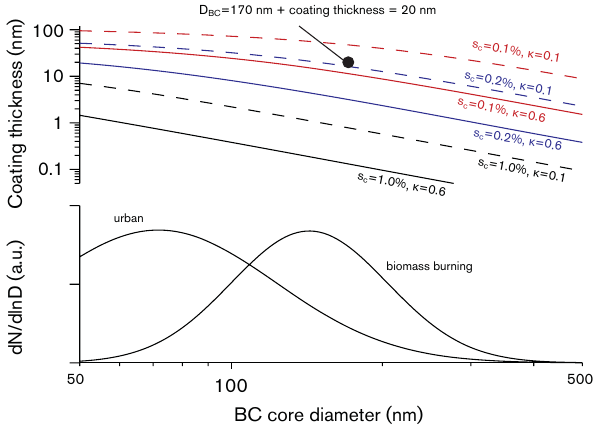
Fig. 6. Bottom plot: number distribution of refractory BC cores size distribution measured in fresh urban and biomass burning plumes reported by Schwarz et al. (2008). Top plot: coating thickness that a soot core must acquire before it can serve as CCN. Black, blue and red colors indicate the 1%, 0.2%, and 0.1% supersaturation threshold. Solid lines and dashed lines are computed assuming that κ of the coating material is 0.6 or 0.1,